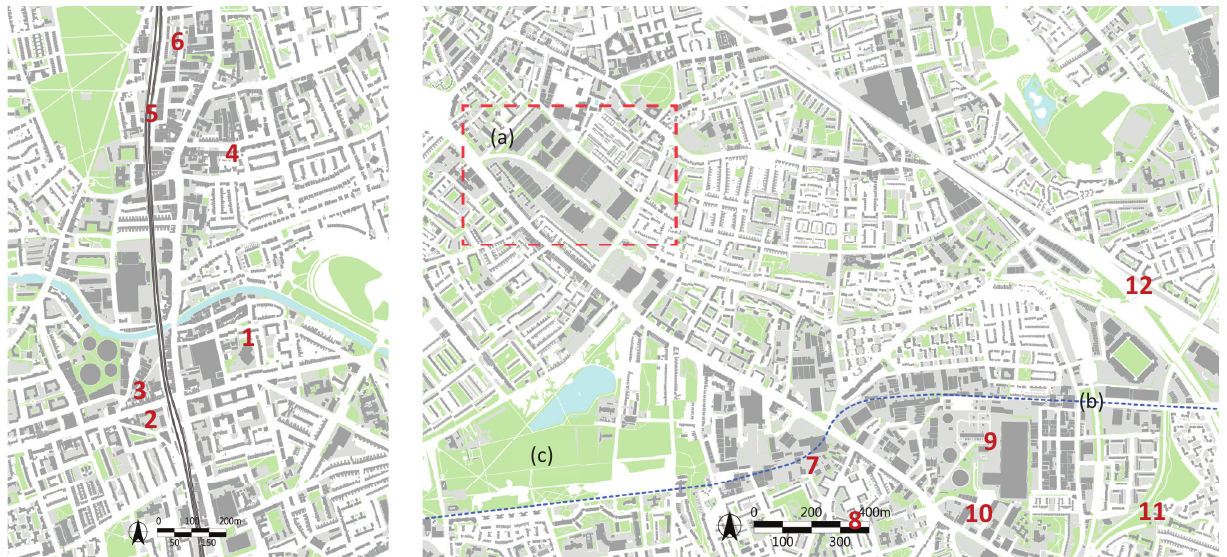
Figure 4. Present day figure‐ground maps of the Hackney Mare Street (left) and the Old Kent Road (right) case studies. On the Old Kent Road map is noted (a) the site of the Bricklayers Arms Station and Goods Depot; (b) the path of the now covered Grand Surrey Canal; and (c) Burgess Park. Base map source: Ordnance Survey (2019). Created 11 December 2020.